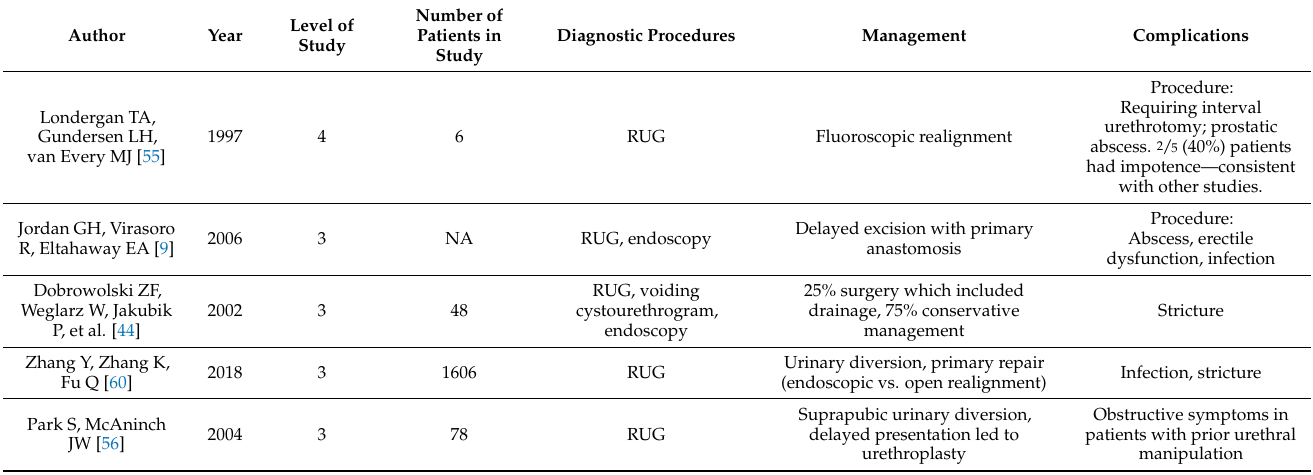
Table 4. Blunt Anterior Urethral